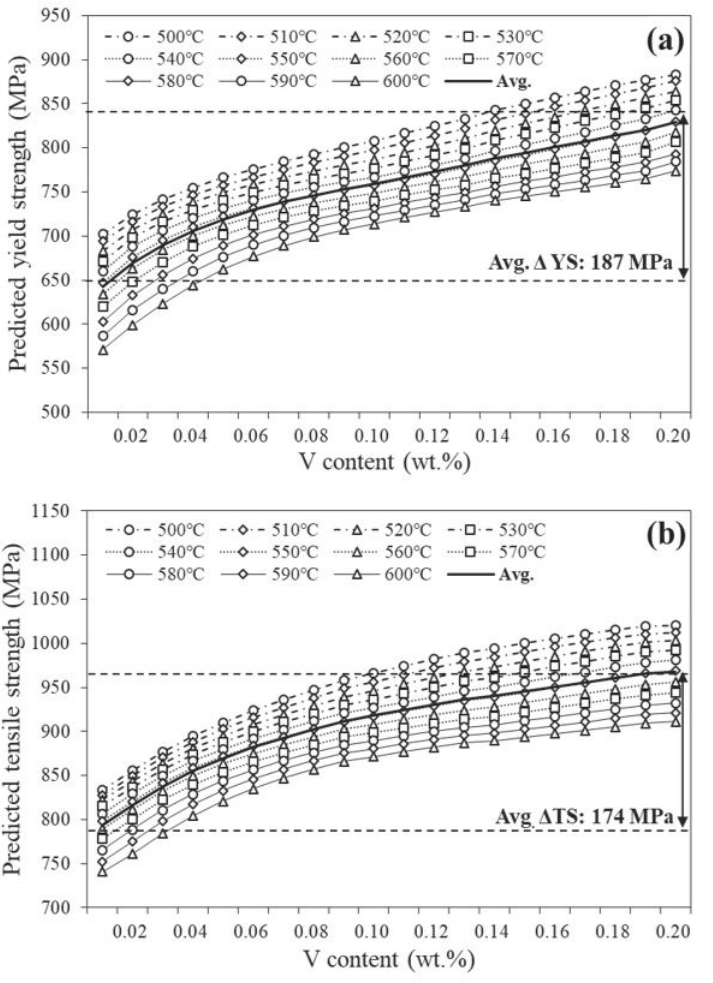
Figure 10. Predicted strengths against V contents for various self-tempering temperatures via ANN modelling: ( a ) yield strength and ( b ) tensile